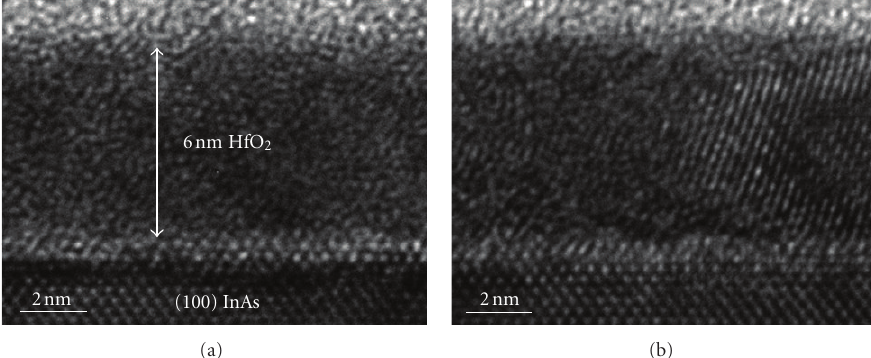
Figure 1: CTEM images of HfO 2 in situ deposited on InP/InAs channel at (a) 200 ◦ C and (b) 300 ◦ C. Abrupt and native oxide free interface provides a promising interface for MOS applications.